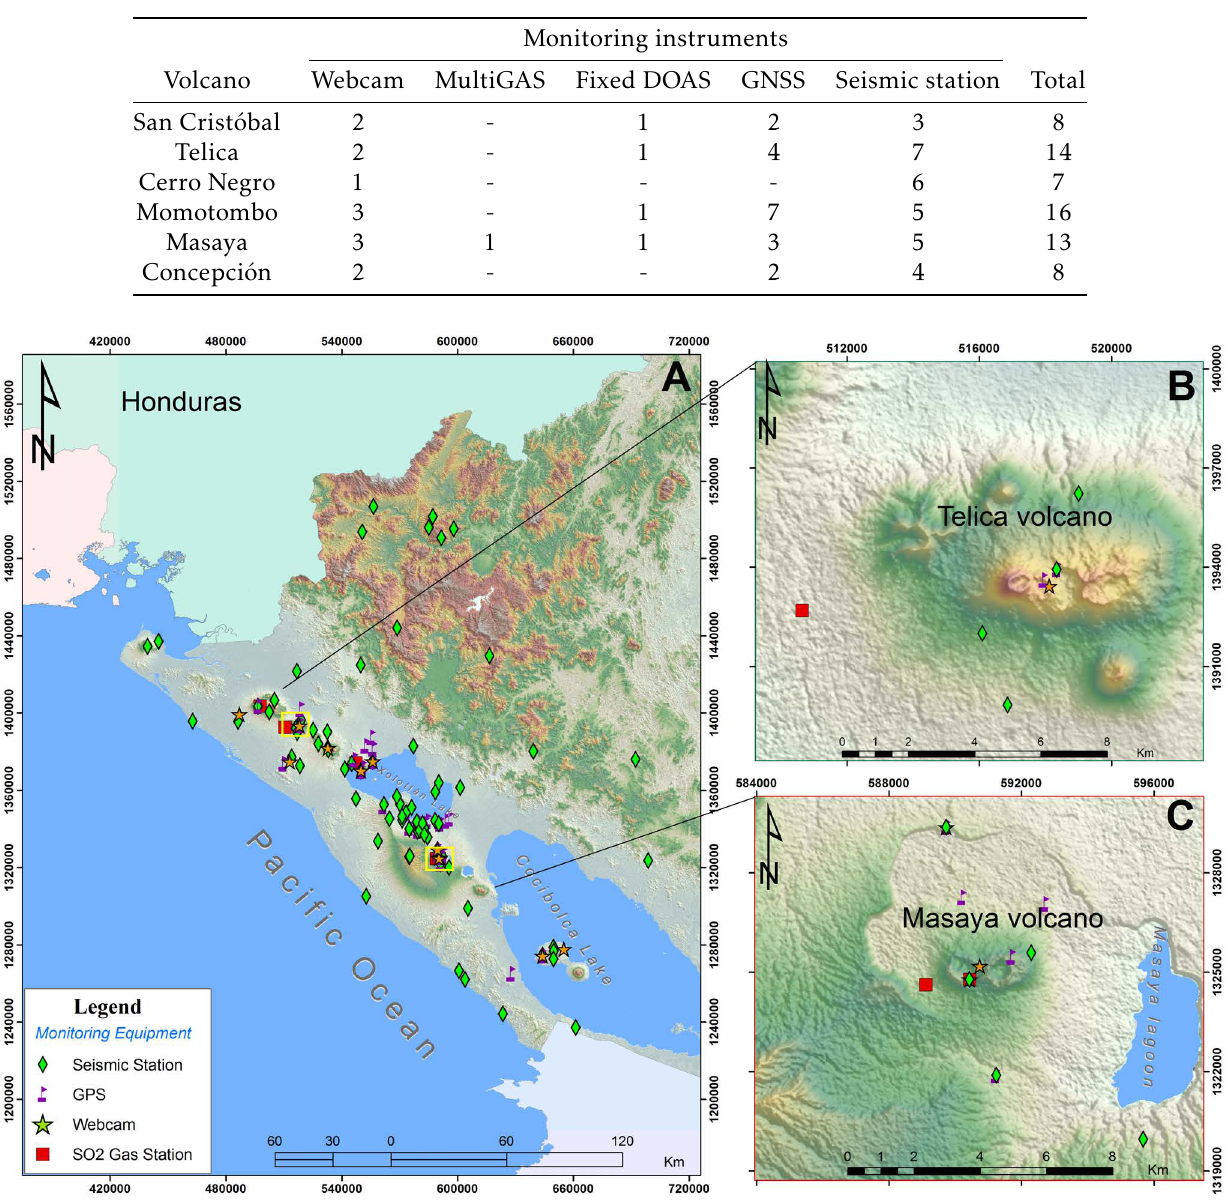
Table 1: Monitoring instruments per volcano operated by INETER, Nicaragua.